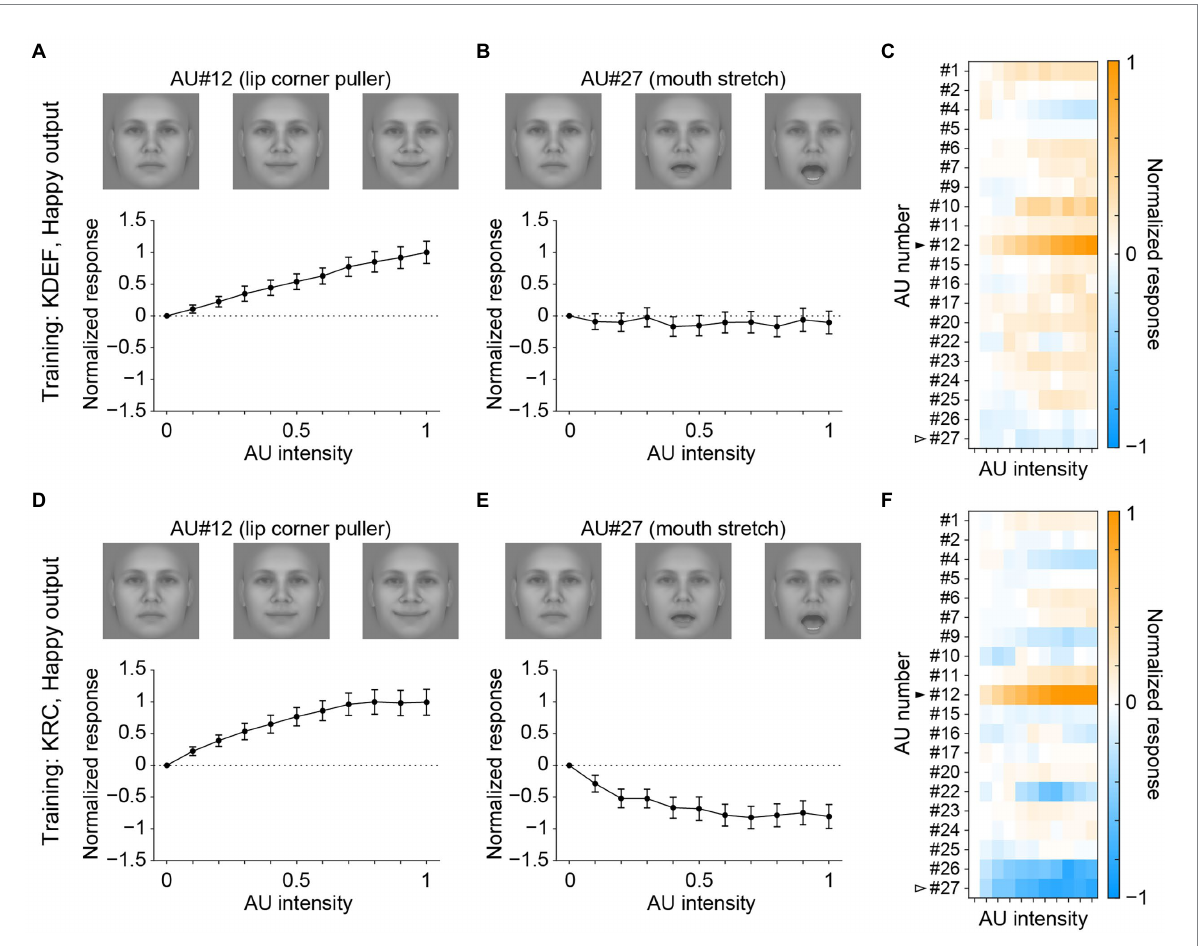
FIGURE 5 Selectivity of the outputs of the “happy” unit in the FC3 layer to the AUs. Responses of the “happy” unit of the KDEF-trained CNNs are shown for varying intensities of AU#12 ( A , lip corner puller) and AU#27 ( B , mouth stretch). The means and standard deviations across 40 runs are plotted. On top, three example images are shown for corresponding AU intensities of 0 (left), 0.5 (middle), and 1 (right). These images of AU manipulations are generated with the neutral female face, FNES, in the Averaged KDEF database (Lundqvist and Litton, 1998; see Tuning to AUs for details). (C) The response profile of the “happy” unit in the KDEF-trained CNNs to all 20 AUs with varying intensities. The mean responses averaged across 40 runs are coded by color (scale bar to the right). The responses are normalized so that the maximum absolute value of the profile becomes 1. Note that the same normalization was also applied to the data shown in (A) and (B) . The filled and open arrowheads indicate AU#12 (shown in A ) and AU#27 (shown in B ), respectively. (D,E) Tuning curves for AU#12 (D) and AU#27 (E) and the response profiles to all 20 AUs of the happy unit in the KRC- trained CNNs (F) . The conventions are the same as in panels (A–C)